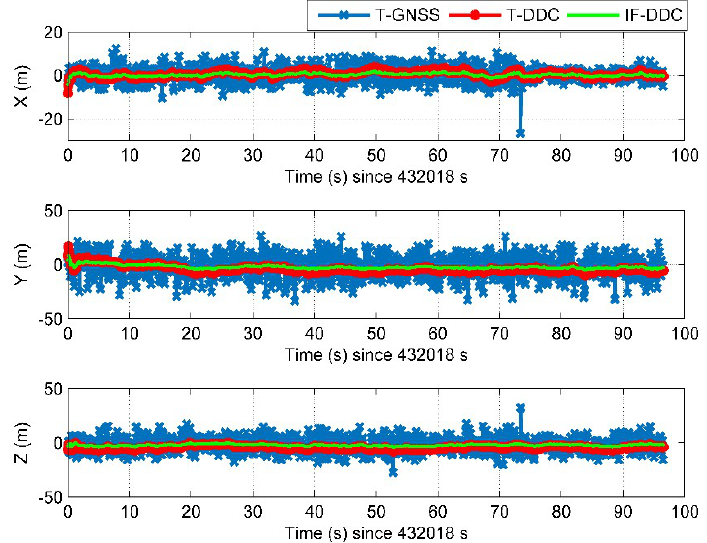
Figure 13. The position errors in the dynamic test using different methods in polar areas.